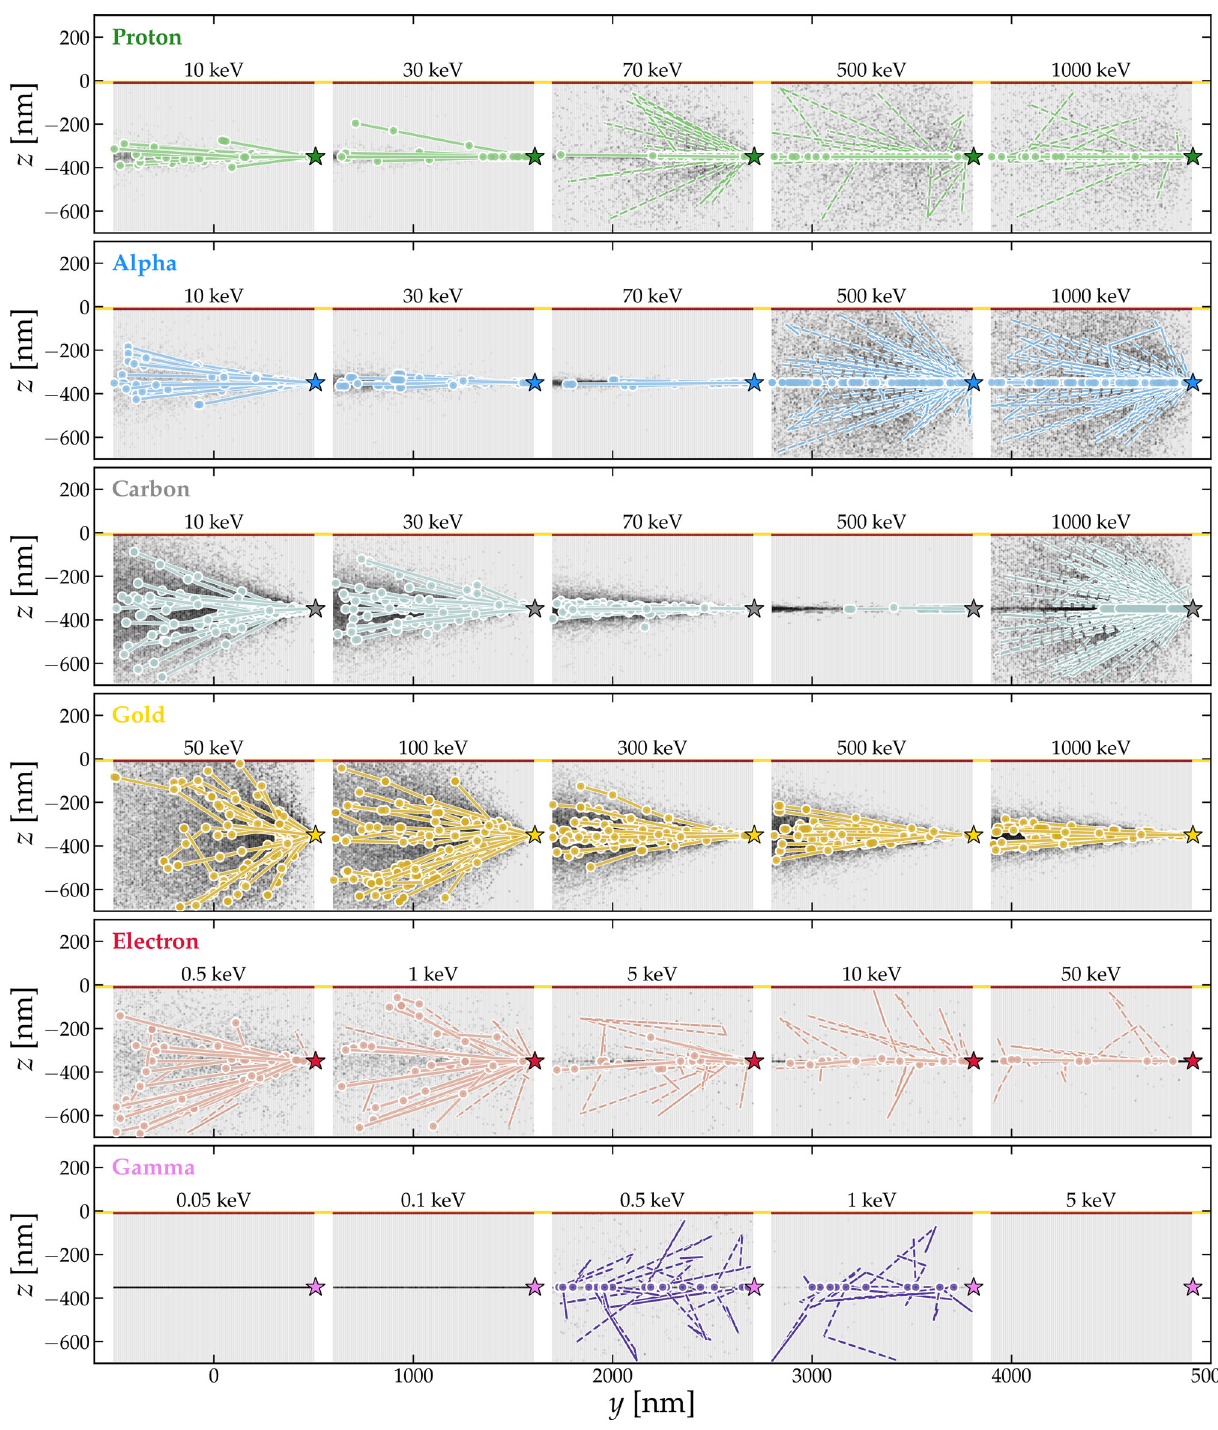
Fig. 10 Additional detailed images of strand breakage from side-on beams. Each row corresponds to a different beam particle, and has five panels for different beam energies. The thick lines connected by circles